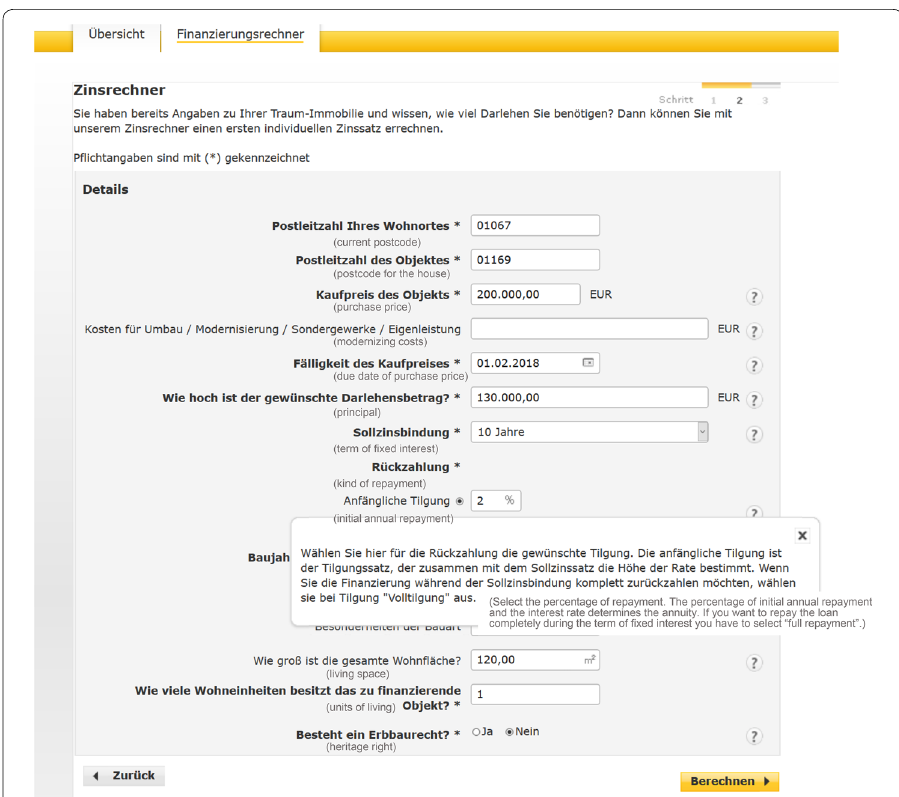
Fig. 1 Screenshots of the CoBa loan calculator. Remark: The design of the calculator is under constant change. Therefore, the screenshots might not totally correspond the current website